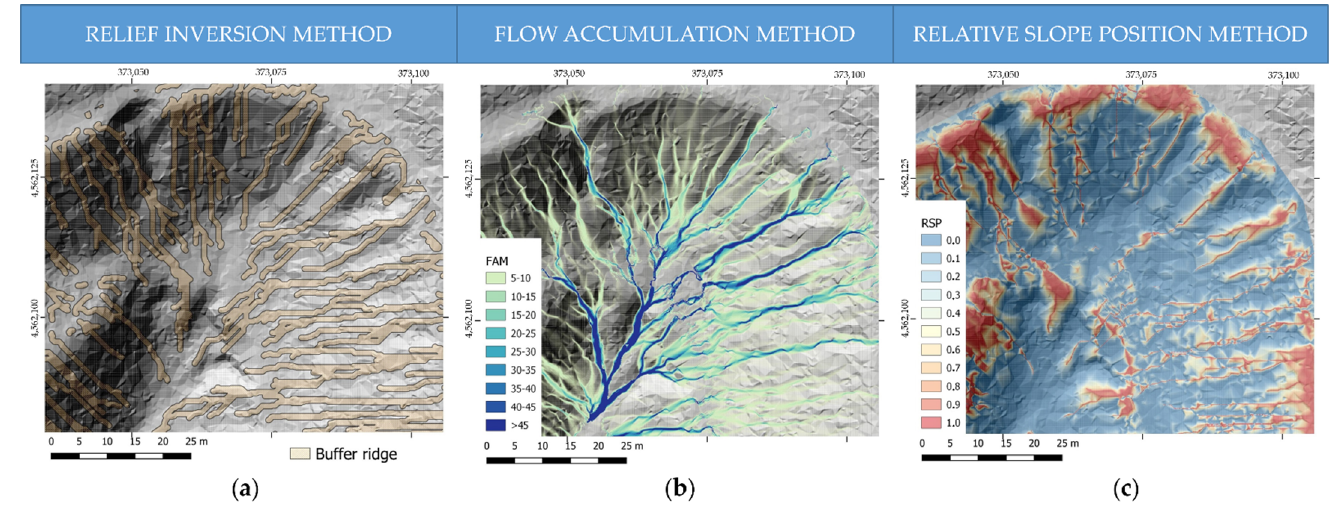
Figure 4. Detail of the cartographic representation of the different methods for detecting gully zones. ( a ) Inverse MDE method, in ochre, the buffer polygon. ( b ) Flow accumulation method, values range from 0 to 5 is represented in transparent which corresponds to the zones with a low flow accumulation or equivalent to the zone without erosion. ( c ) Relative slope position method, where values range from 0.7 to 1 represents areas not affected by erosion.